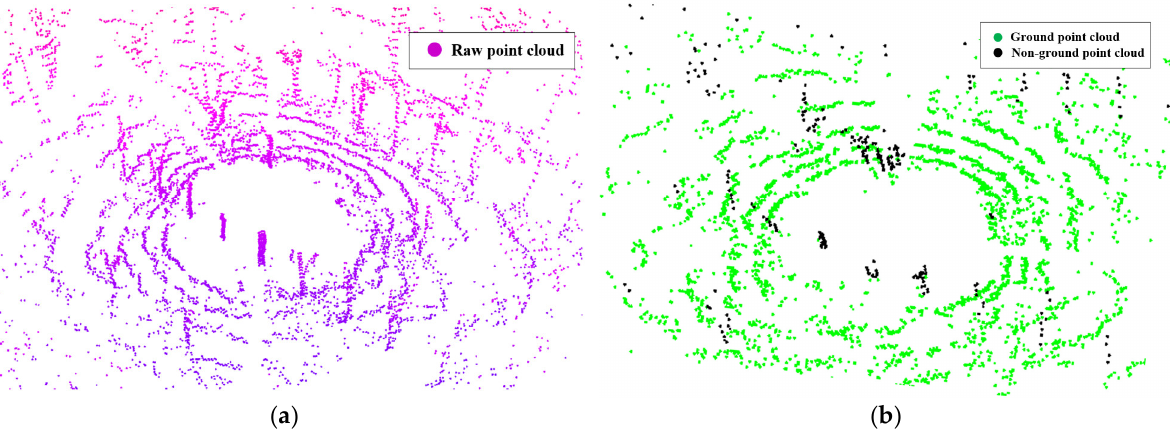
Figure 6. Results of point cloud clustering: ( a ) Raw point cloud; ( b ) the point cloud after clustering. Then, the clustered point cloud planar features are divided again into 6 regions equally according to the LiDAR horizontal scanning angle (0 ∼ 360°), and the same row index number c in each region is regarded as a subset. Drawing on the method of BFS search, the five points adjacent to the left and right of the point cloud particles p t in the same i subset are taken for comparison each time. The smoothness S i of each point cloud particle in the same subset is calculated by substituting the point cloud particles into Equation (3) according to the distance between the neighboring points p t and p t . When the smoothness j i S i of the point cloud particles is greater than the set threshold S th (set to 5 × 10 − 3 ) then it is an edge feature, and conversely, S i is less than the set threshold then it is a surface feature.